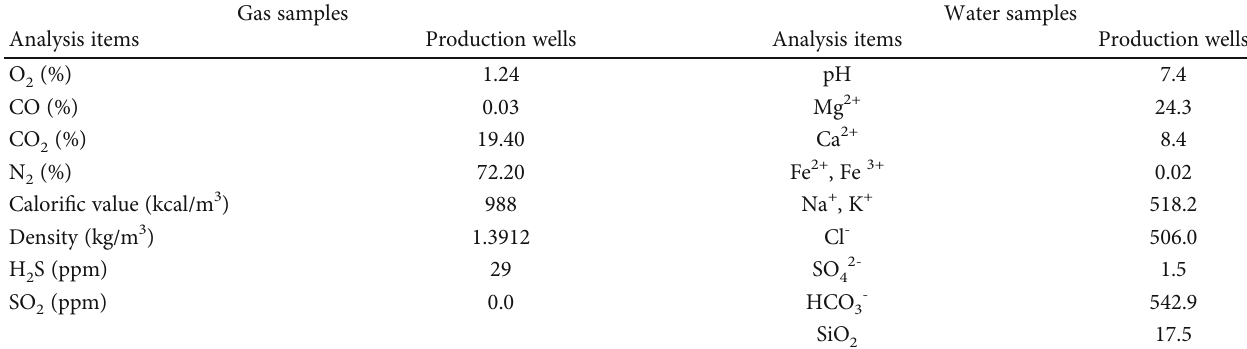
Table 1: Analysis results of gas/liquid samples in the production